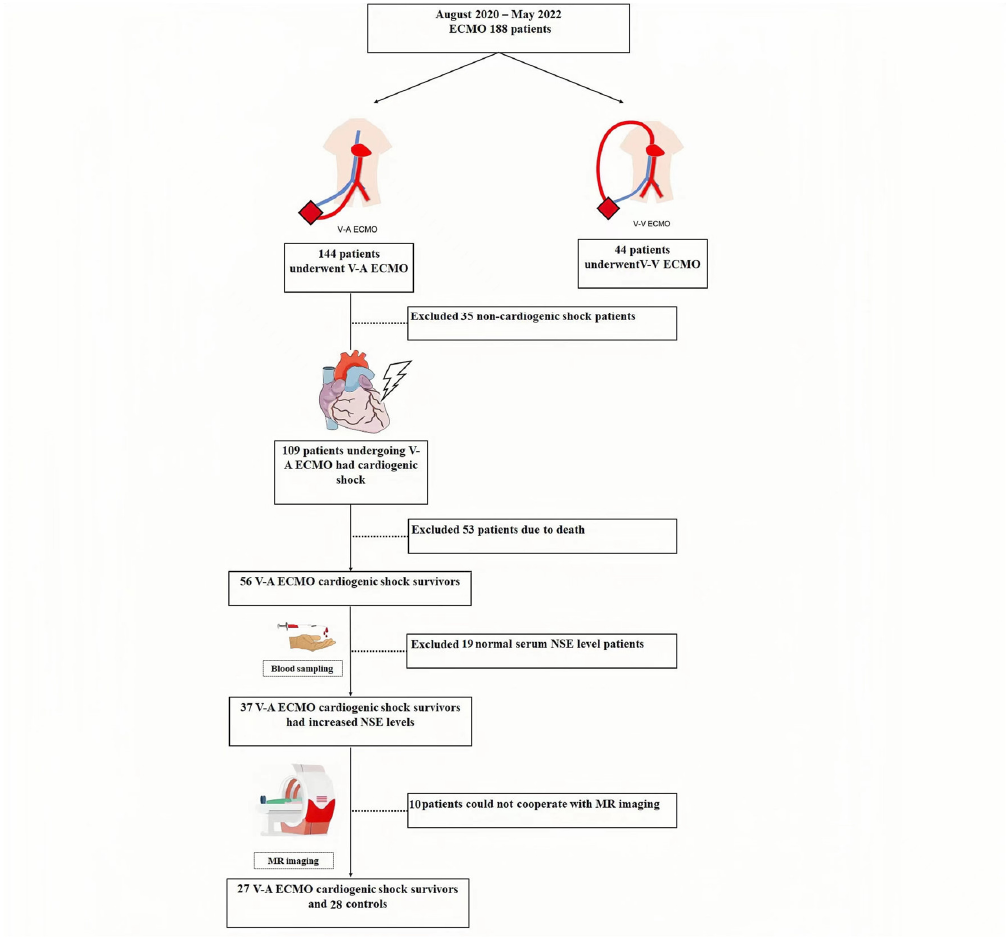
Figure 1. Schematic flow chart of our study participants. Table 1. Demographics of our study participants.